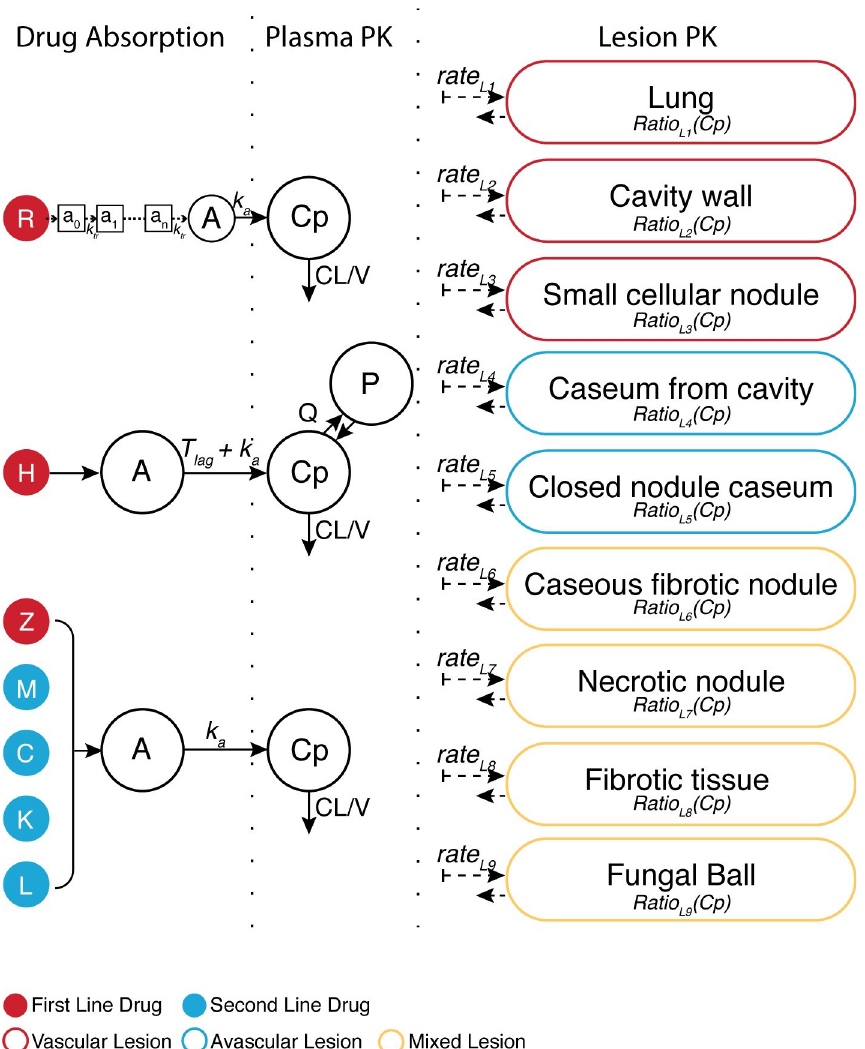
Fig 3. PK structural model. First-line drugs R, H, and PZA and second-line drugs M, C, K, and L were modeled individually with parameters CL, V, and k a from an A describing Cps. R required a transit model to capture absorption, and H required an additional compartment (P) with Q and lag in time before absorption (Tlag) to model plasma data. Tissue concentration–time profiles were modeled with the addition of 2 parameters to describe the rate of drug absorption into the tissue compartment and the ratio of observed tissue concentration to plasma concentration. A, absorption compartment; C, clofazimine; CL, clearance; Cp, plasma concentration; H, isoniazid; K, kanamycin; k a , rate of absorption; L, linezolid; M, moxifloxacin; P, peripheral compartment; PK, pharmacokinetic; PZA, pyrazinamide; Q, intercompartmental clearance; R, rifampicin; V,